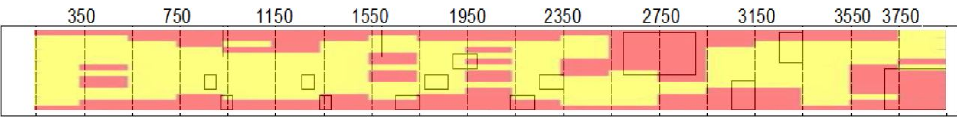
Figure 10. Damage detection with 34 training points, 40 hidden layer neurons, and 1000 iterations.